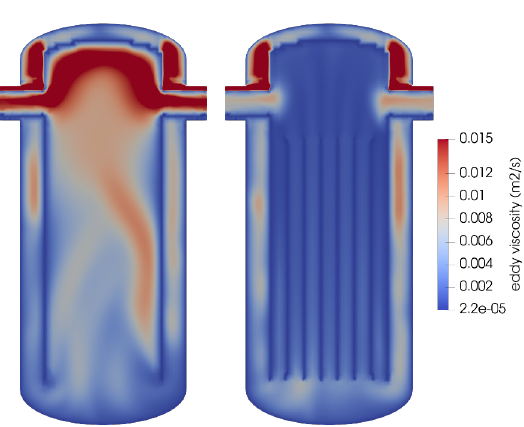
Figure 2: Eddy viscosity in clear (left) and baffled (right) cores.